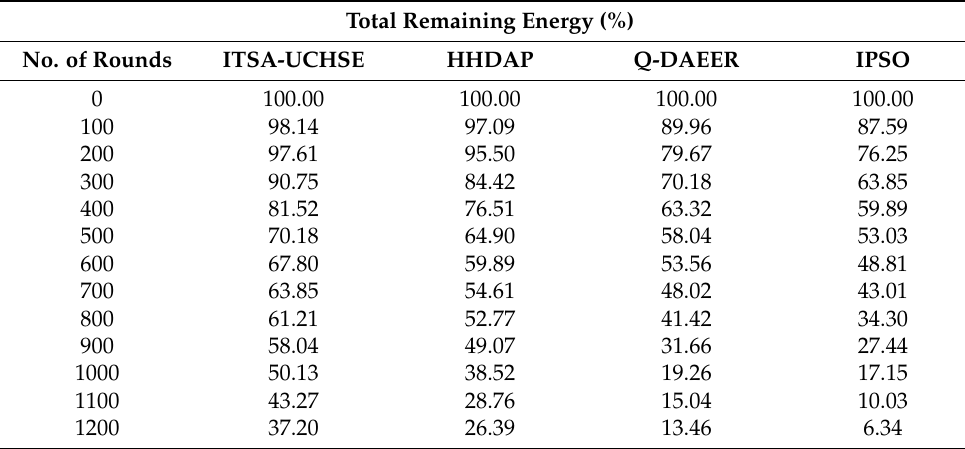
Table 6. TRE analysis of ITSA-UCHSE system with current methods under distinct